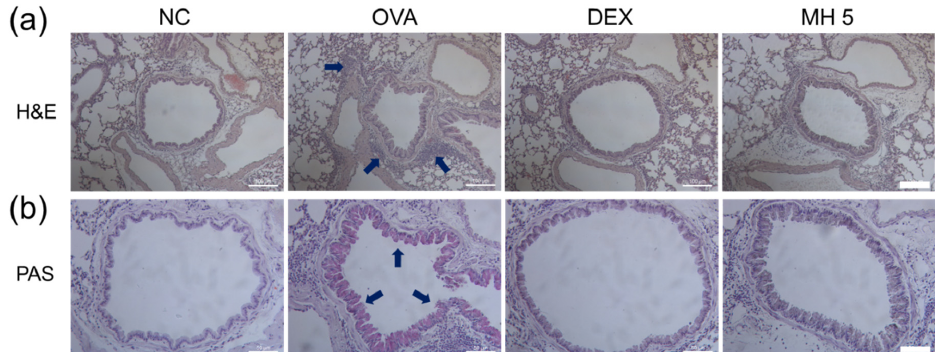
Figure 8. Effects of MH on immune cell influx and mucus generation in mice with AA. ( a ) The existence of immune cells surrounding the airway was confirmed using H&E staining (magnification, ×100; scale bar, 100 μ M). ( b ) Airway mucus was detected using PAS staining (magnification, ×200; scale bar, 50 μ M).